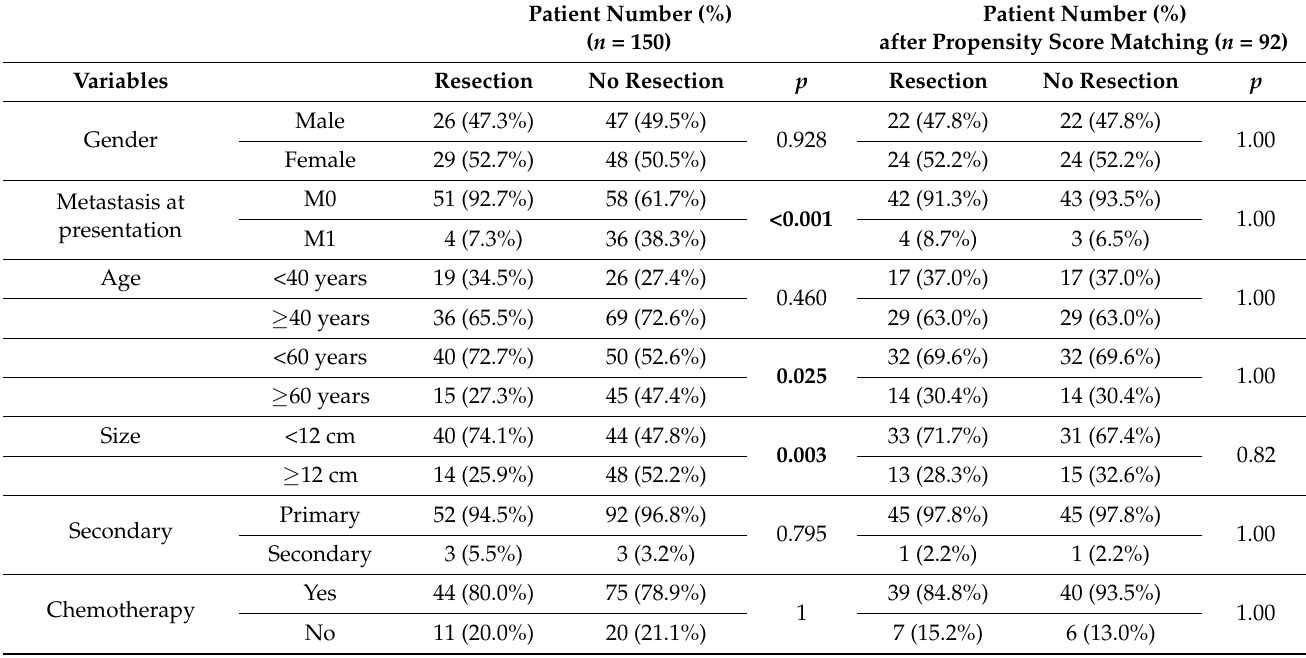
Table 4. Characteristics of the pelvic osteosarcoma treated with or without surgical resection before and after propensity score matching.